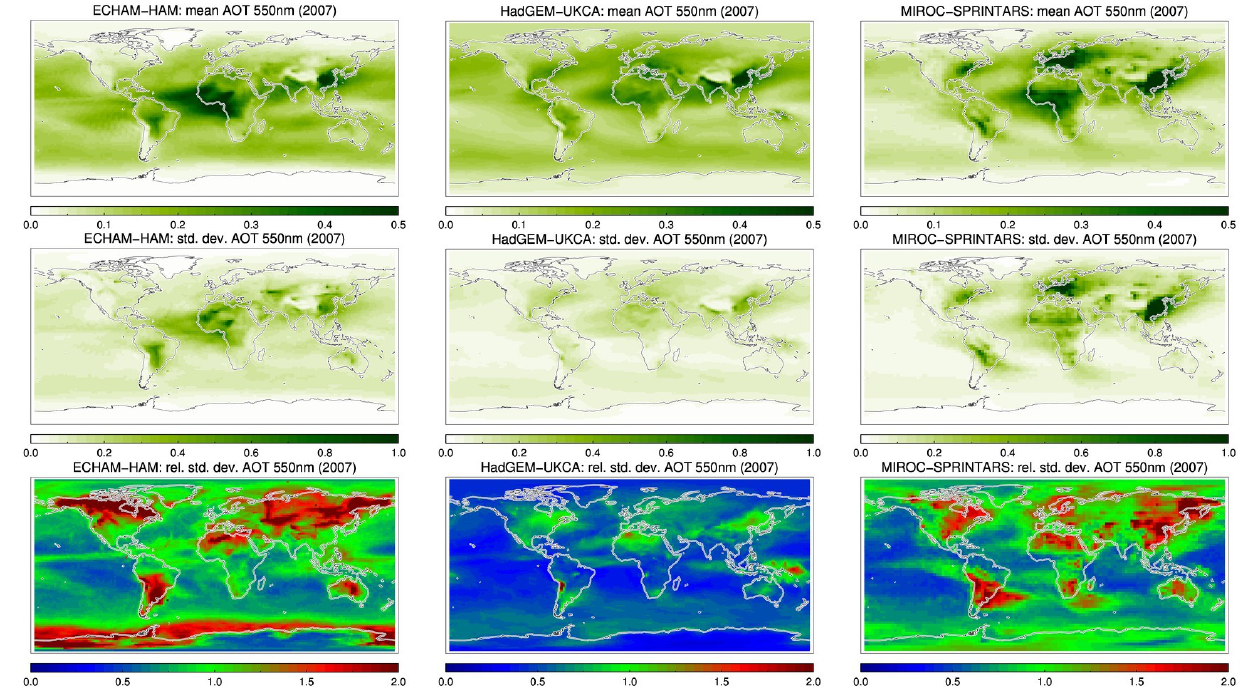
Figure 2. Global maps of yearly mean, standard deviation, and relative standard deviation in AOT.